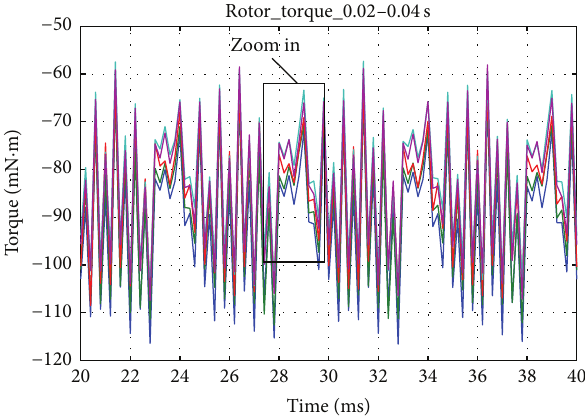
Figure 12: Relationship between axial displacement and the electromagnetic